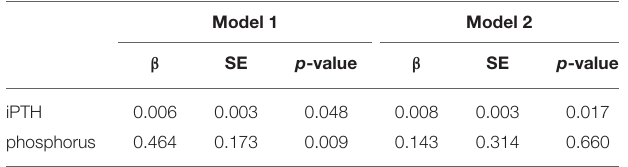
TABLE 4 | Associations of PTH and phosphorus with endoPAT by multiple linear regression analyses.